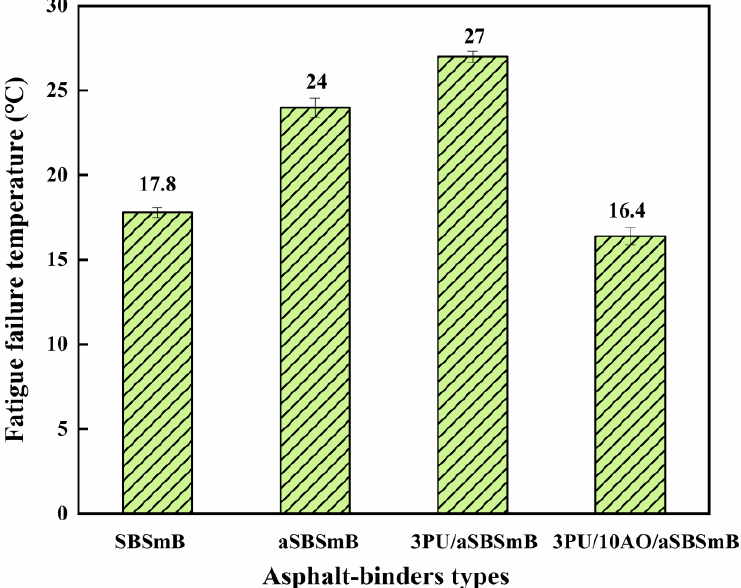
Figure 8. Effect of reaction rejuvenation on the fatigue failure temperature of aSBSmB.